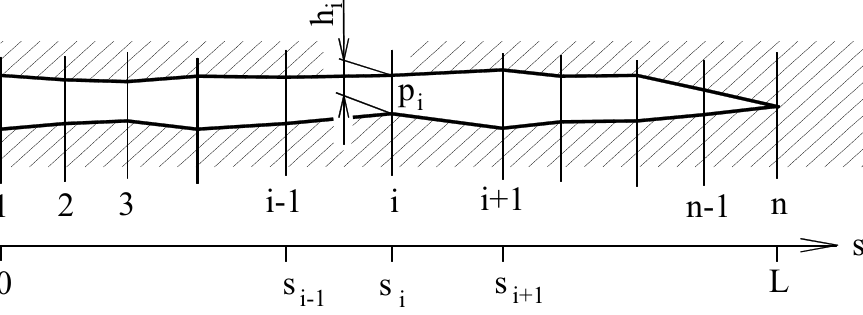
Figure 4: The way of crack discretisation by means of its sectional division using n perpendicular